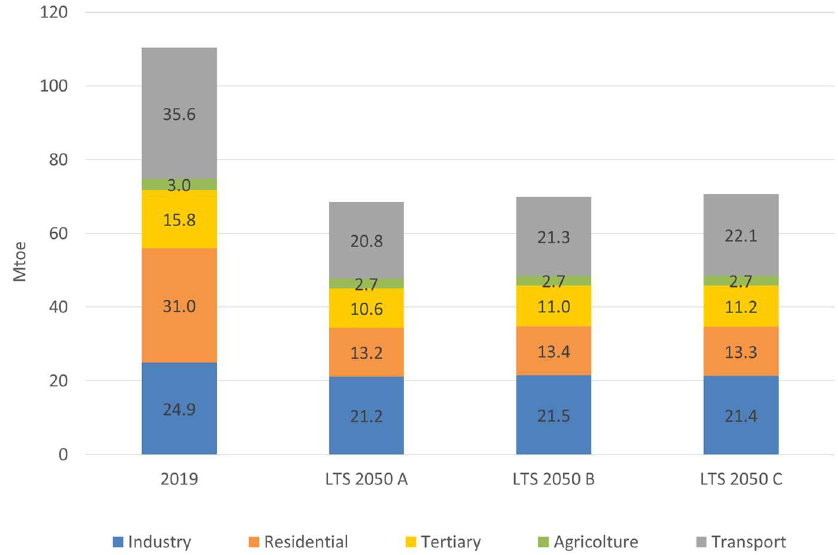
Figure 8. Expected evolution of final energy consumption by sector: comparison between the current state (2019) and the decarbonization scenario.